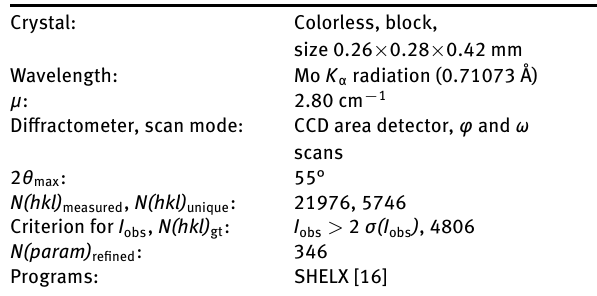
Table 2: Fractional atomic coordinates and isotropic or equivalent isotropic displacement parameters (Å 2 ).